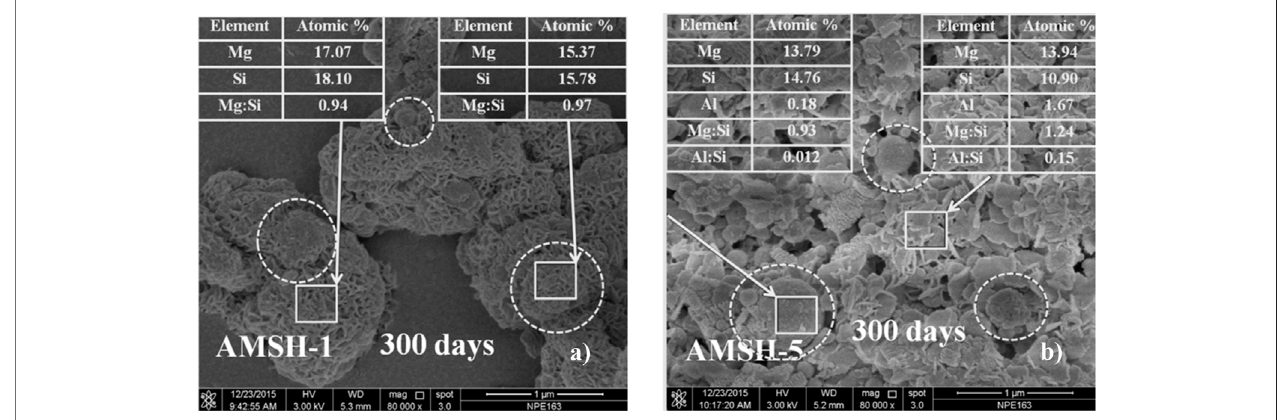
FIGURE 4 | Field emission scanning electron microscope (F-SEM) images of samples with different Al/Si molar ratios after curing for 300 days: (A) 0 and (B) 0.2.